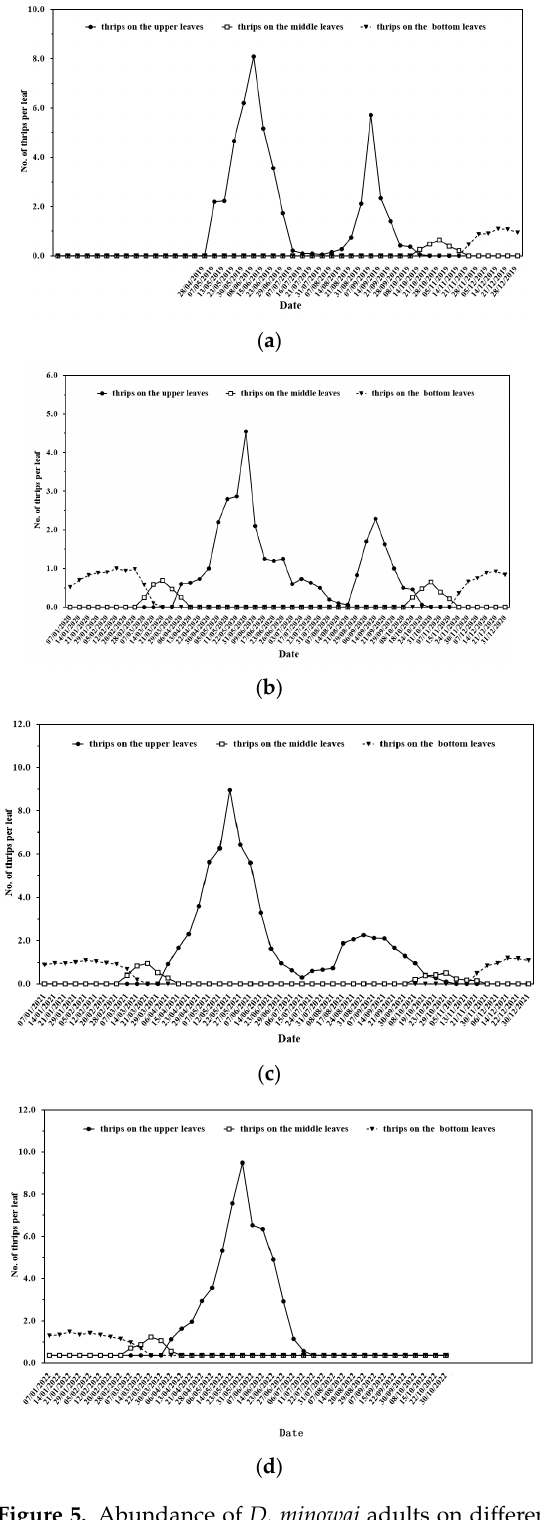
Figure 5. Abundance of D. minowai adults on different parts of tea leaves (upper leaves, middle leaves, and bottom leaves) in 2019–2022. ( a ) Shaoxing in 2019; ( b ) Shaoxing in 2020; ( c ) Shaoxing in 2021; and ( d ) Shaoxing in